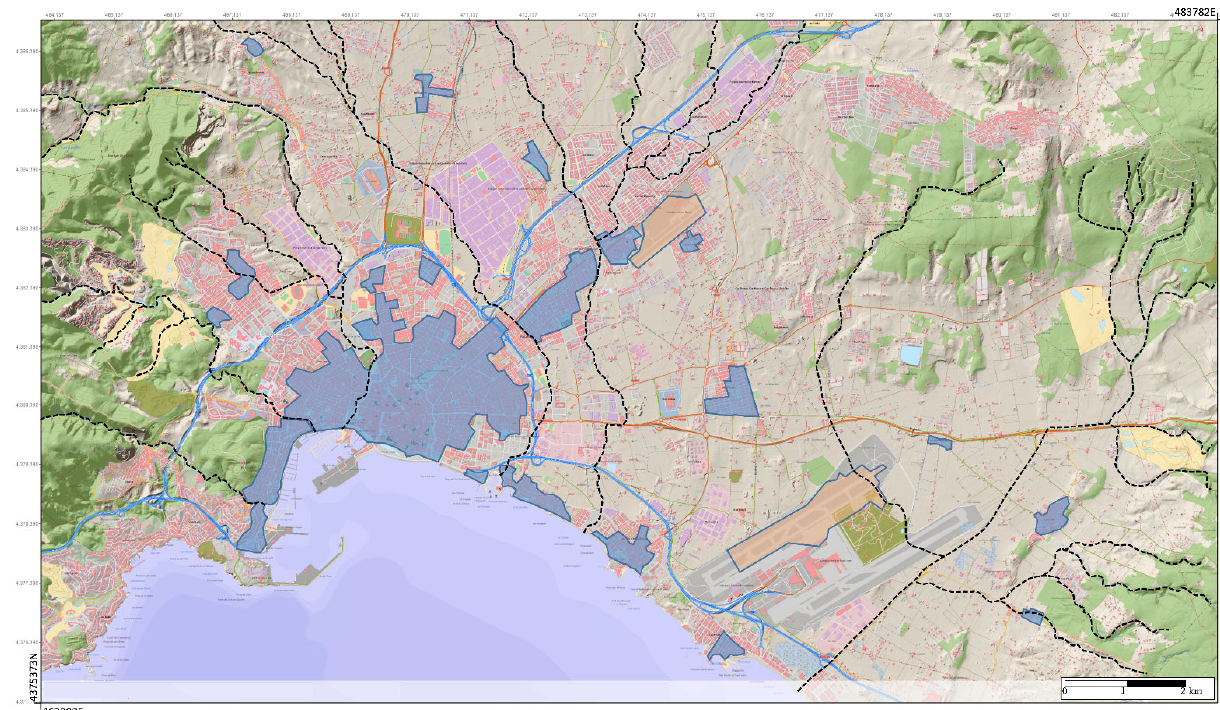
Figure 2. Urban expansion of Palma. In sky blue the urbanized areas in 1956. Pink shades show the urbanized areas as of 2018 and black dotted line shows the surface stream network of the basin.